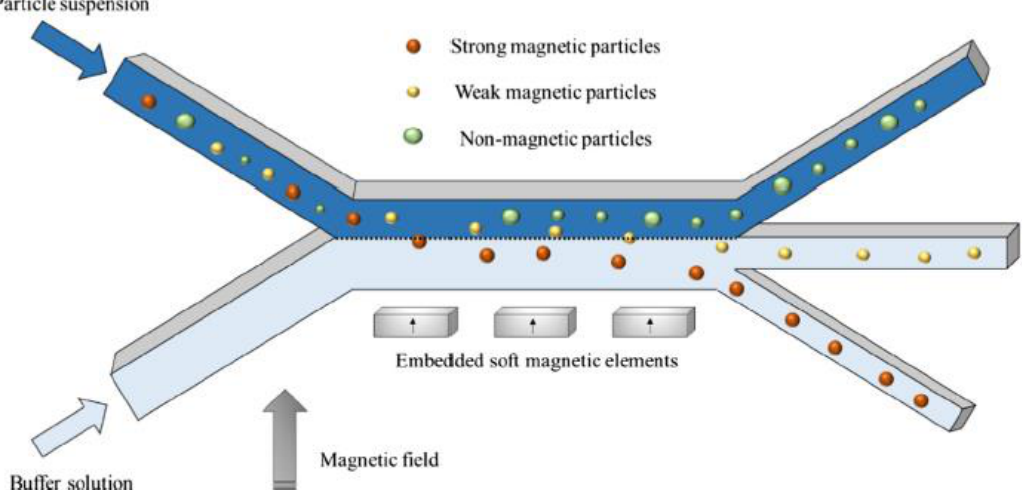
Figure 2. Separation of magnetic and non-magnetic materials inside a continuous-flow magneto- phoretic microdevice [79]. Reprinted with permission from Ref. [79], 2022, Elsevier.